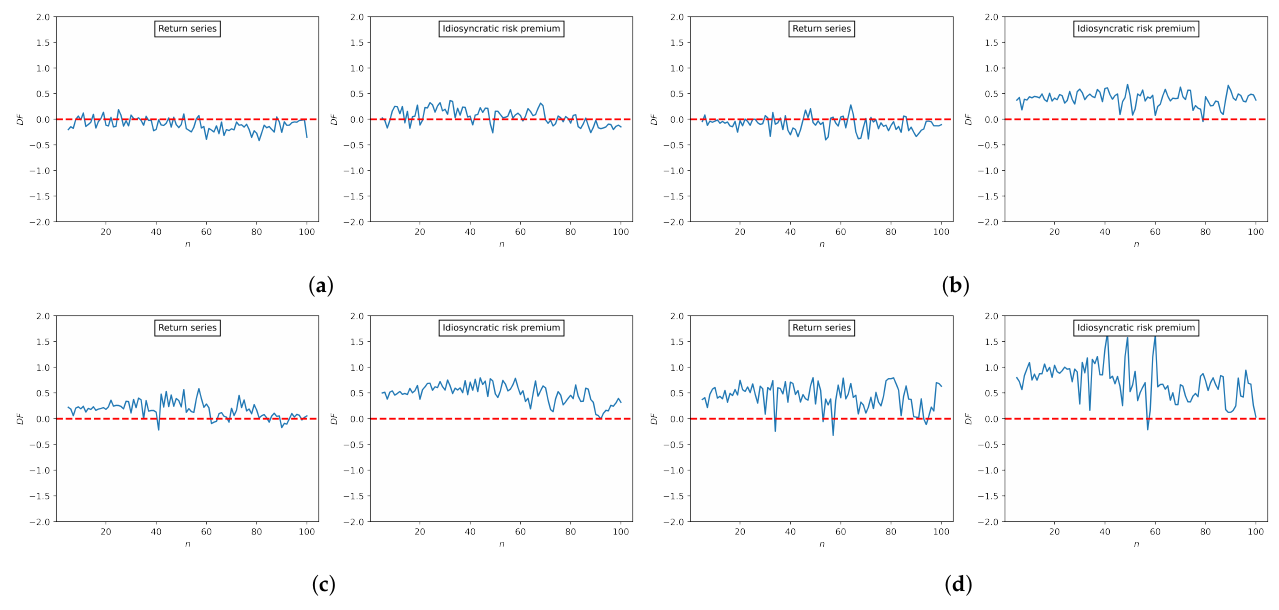
Figure 5. Plots of DF with index-based A-MFDFA. ( a ) BTC. ( b ) ETH. ( c ) ADA. ( d ) XRP. Note that the red dashed horizontal line indicates a symmetry between uptrend and downtrend